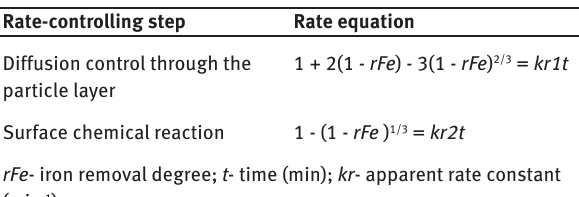
Figure 13. Plots of 1 − (1 − r Fe ) 1/3 vs time for different parameters: (a) ratio of NH 4 Cl to EBFS mass and (b) particle size.